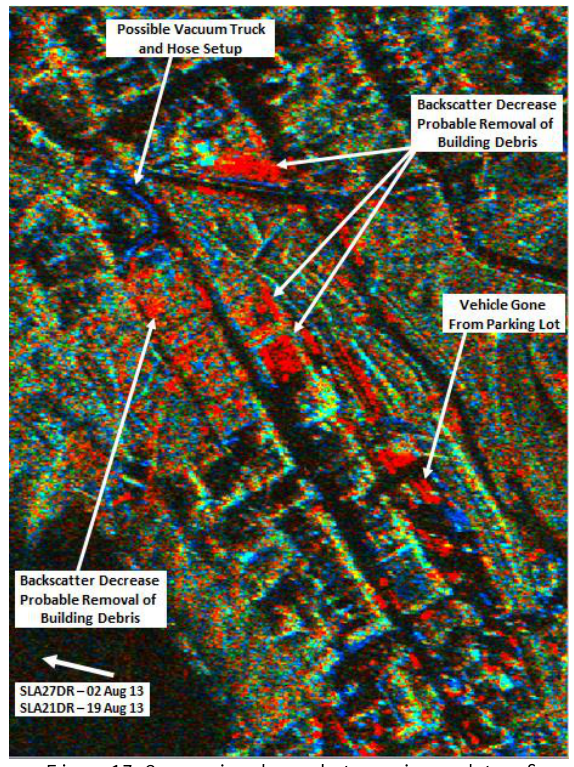
Figure 17. Comparing change between image dates of 2 August, 2013 and 19 August, 2013. RADARSAT-2 Data and Products © MacDonald, Dettwiler and Associates Ltd. 2013. All Rights Reserved. RADARSAT is an official mark of the Canadian Space Agency.